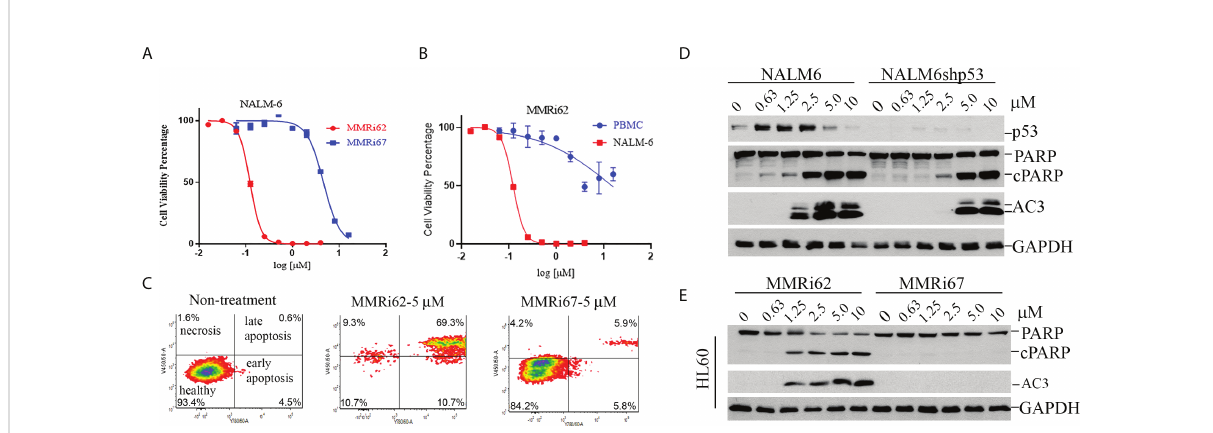
FIGURE 4 MMRi62 but not MMRi67 inhibited the proliferation of leukemic cells by inducing p53-independent apoptosis with low toxicity for healthy peripheral blood monocytes (PBMCs). (A) Growth curves of wt-p53 NALM6 cells in the presence of different concentrations of MMRi62 or MMRi67 in 72-h proliferation assays. (B) Growth curve of PBMCs in the presence of different concentrations of MMRi62 in comparison with that of NALM6 cells replotted from the same dataset in panel (A) PBMC proliferation was stimulated by 10 m g/ml of pokeweed mitogen (PWM). (C) Flow cytometry analysis of annexin-V-positive apoptotic cells after 48-h treatment with 5 mM of MMRi62 or MMRi67. (D) Concentration- dependent caspase-3 activation (AC3) and PARP cleavage (cPARP) in NALM6 cells and NALM6shp53 cells stably expressing shRNA against p53. The cells were treated with the indicated concentrations of either MMRi62 or MMRi67 for 24 h followed by Western blotting (WB) analysis with corresponding antibodies. (E) Similar analysis as in panel (D) except using p53-null HL60